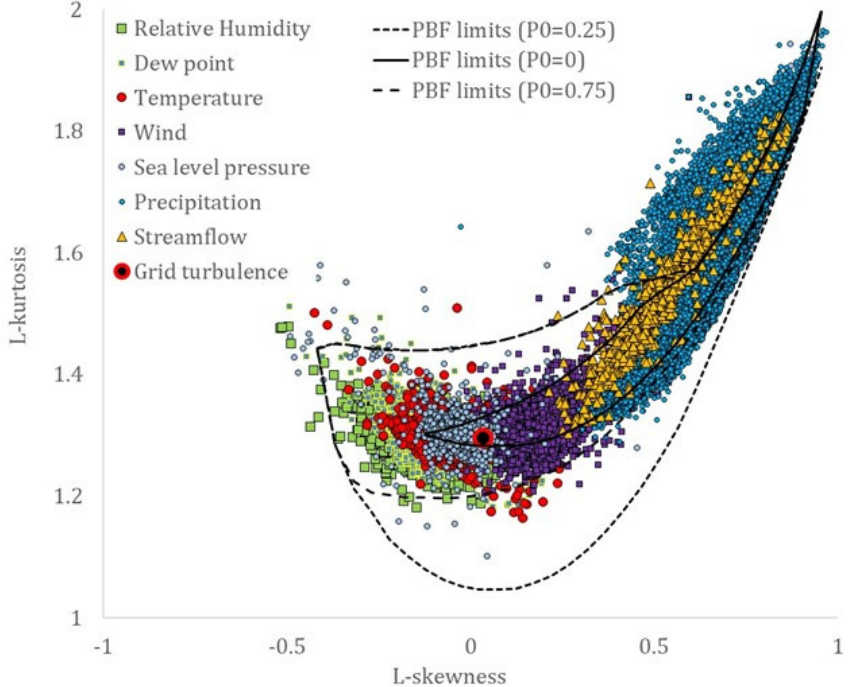
Figure 10. L-skewness vs. L-kurtosis (modified, i.e., 4/5 × λ 4 / λ 2 + 6/5), estimated through the hyper-central K-moments, for the key hydrological-cycle and the grid-turbulence processes, and the empirically calculated limits of the mixed Pareto-Burr-Feller distribution for different probabilities of zero values.